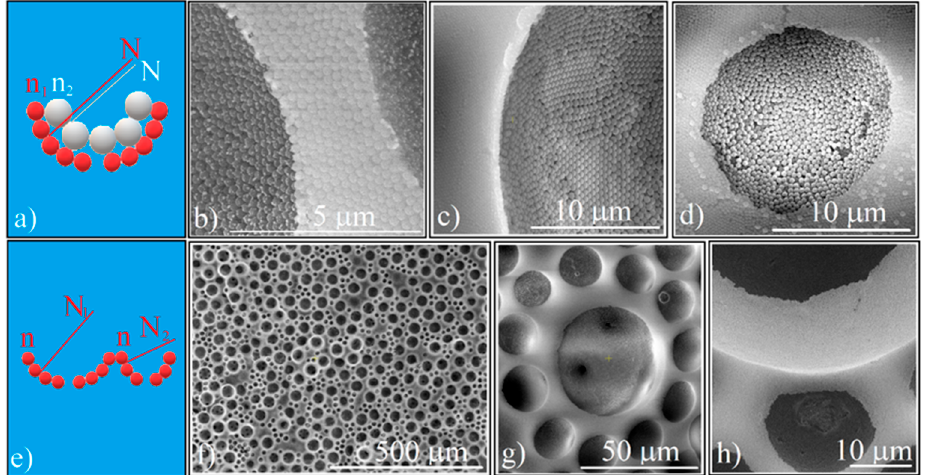
Figure 6. ( a ) Schematical of 2D high complexity superstructures which have an ordered concavity as structural unit (same normal different refractive indices); ( b ) SEM image of Au colloidal particles deposited on the silica ordered concavity wall; ( c ) SEM image of polystyrene (0.488 µm) colloidal particles deposited on the silica ordered concavity wall; ( d ) SEM image of fluorescent silica (0.384 µm) colloidal particles deposited on the silica (0.264 µm) ordered concavity wall ( e ) Schematical of 2D high complexity superstructures which have an ordered concavity as structural unit (different normal, same refractive index); ( f ) SEM image of binary ordered concavity array; ( g , h ) SEM images of ordered concavities of different diameter.